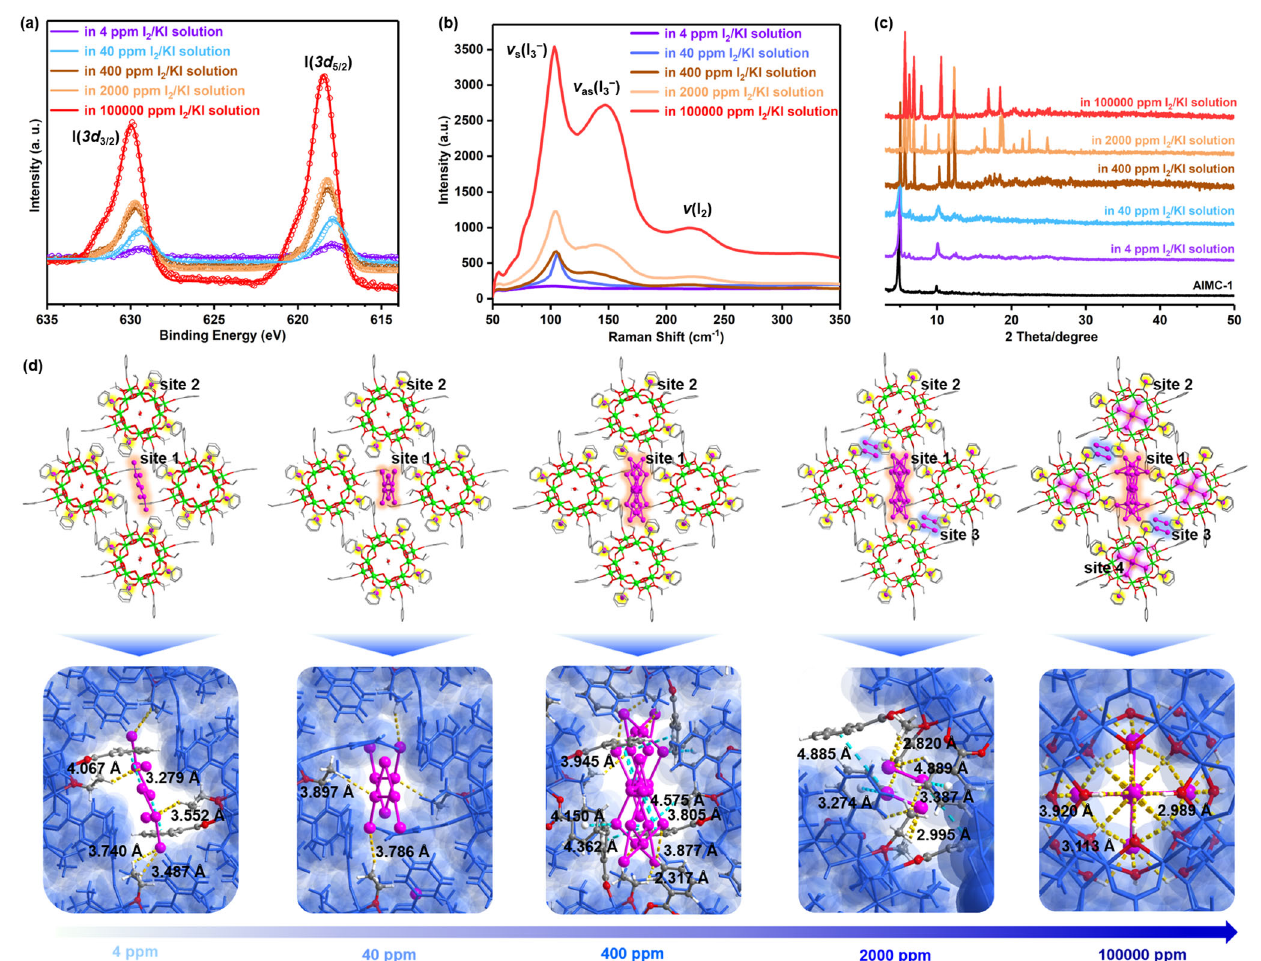
Fig. 6 | Characterization and mechanism of the iodine capture processes of AlMC-1 in 4 – 100,000ppm I 2 /KI aqueous solutions. Macroscopic characteriza- tion of AlMC-1 after immersing in 4 – 100,000ppm I 2 /KI aqueous solutions, including a expanded XPS spectra, b Raman spectra, and c PXRD patterns. d Mechanisticstudiesatthemolecularlevel(toprow:adsorptionsite;bottomrow: corresponding supramolecular interactions between iodine species and Al 24 cage